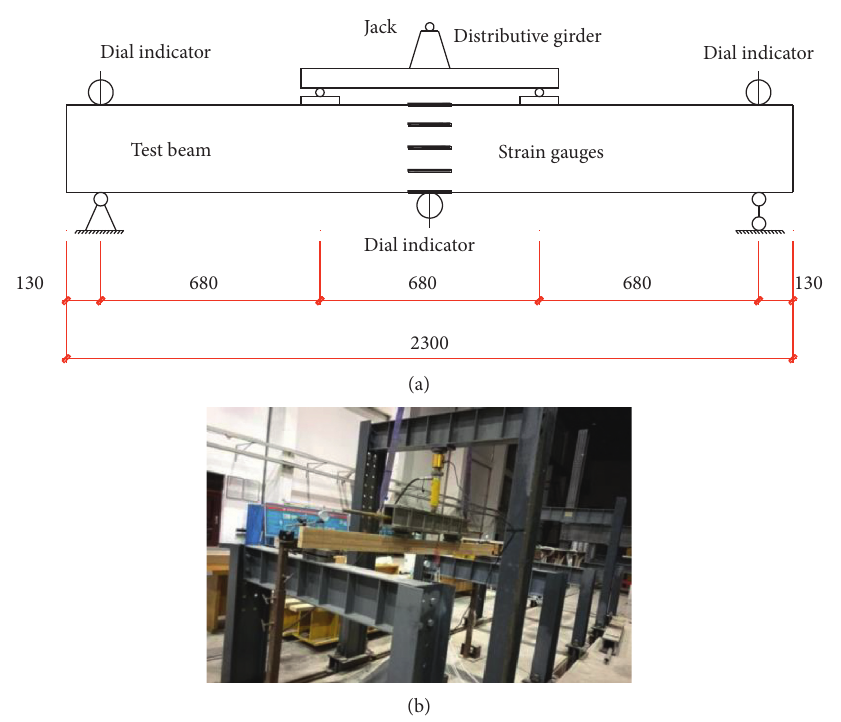
Figure 1: Test apparatus loading with two-point. (a) Loading schematic diagram. (b) Testing field.